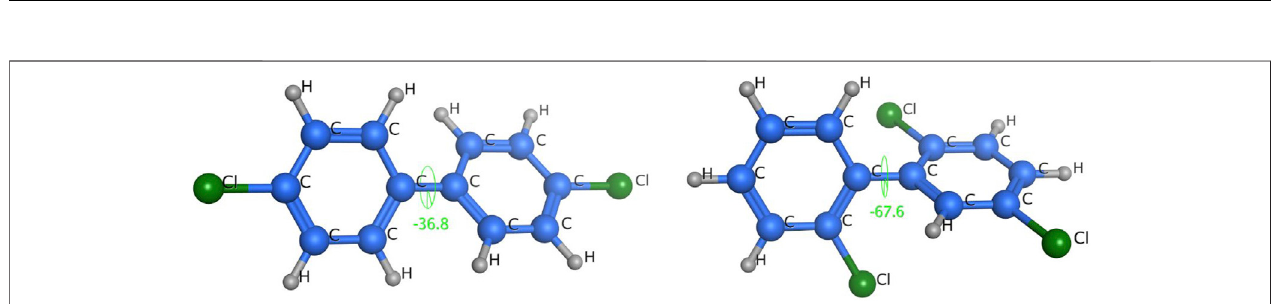
FIGURE 10 | Geometric structures and dihedral angles of 2,2 ʹ ,5-trichlorobiphenyl and 4,4 ʹ -dichlorobiphenyl.